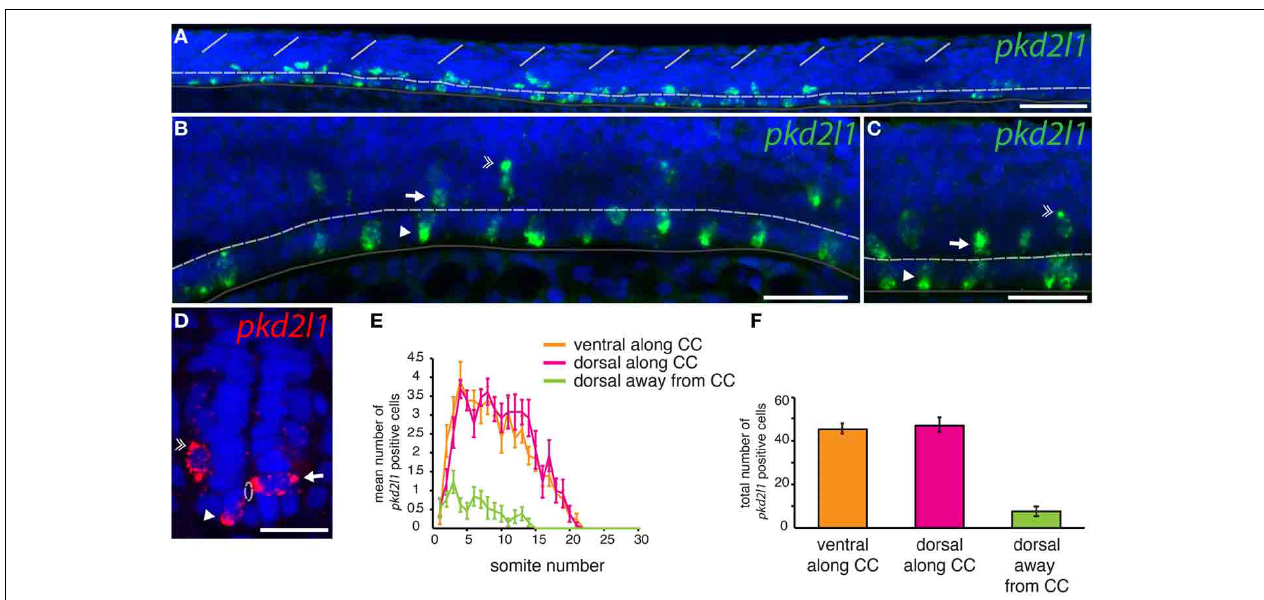
FIGURE 5 | pkd2l1 is expressed in cells contacting the CSF and surrounding the central canal in the spinal cord of the zebrafish embryo. (A–D) FISH of pkd2l1 mRNA at the 30-somite stage. Lateral views for (A–C) and transverse section for (D) . Two subpopulations of pkd2l1 bright expressing cells surround the central canal ventrally (arrowhead) and dorsally (arrow). Note the existence of dorsal pkd2l1 weak expressing cells away from the central canal (double arrowhead). The white dashed line, dark gray solid line and the solid white lines